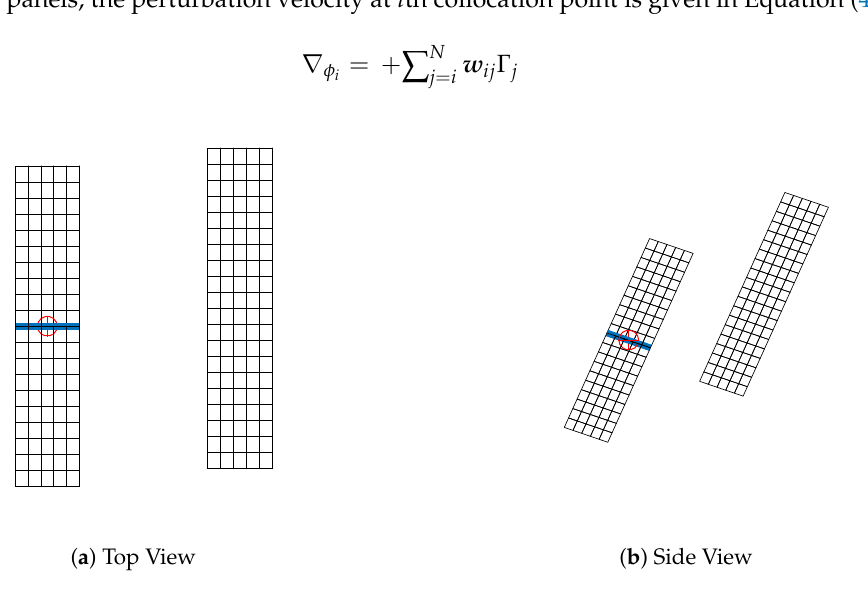
Figure 1. Panel distribution on rectangular